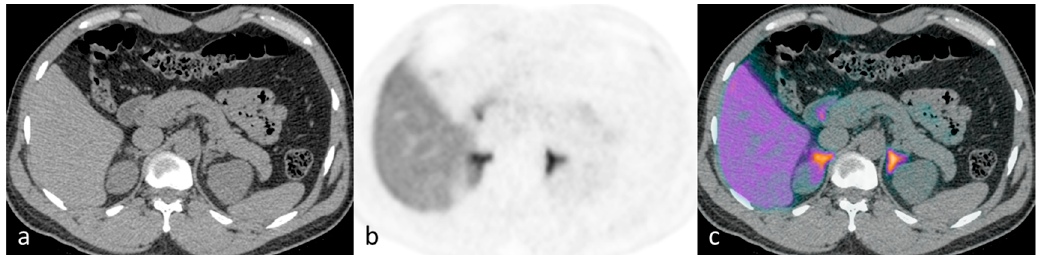
Figure 4. Illustrative case 4: A 40-year-old man with a five-year history of hypertension and hypokalaemia had a diagnosis of hyperaldosteronism confirmed by failure to suppress aldosterone following saline infusion. CT findings were equivocal, showing a possible small right adrenal nodule ( a ). Tracer uptake was symmetrical bilaterally on 11 C-metomidate PET-CT ( b , c ). His bilateral disease is managed medically.